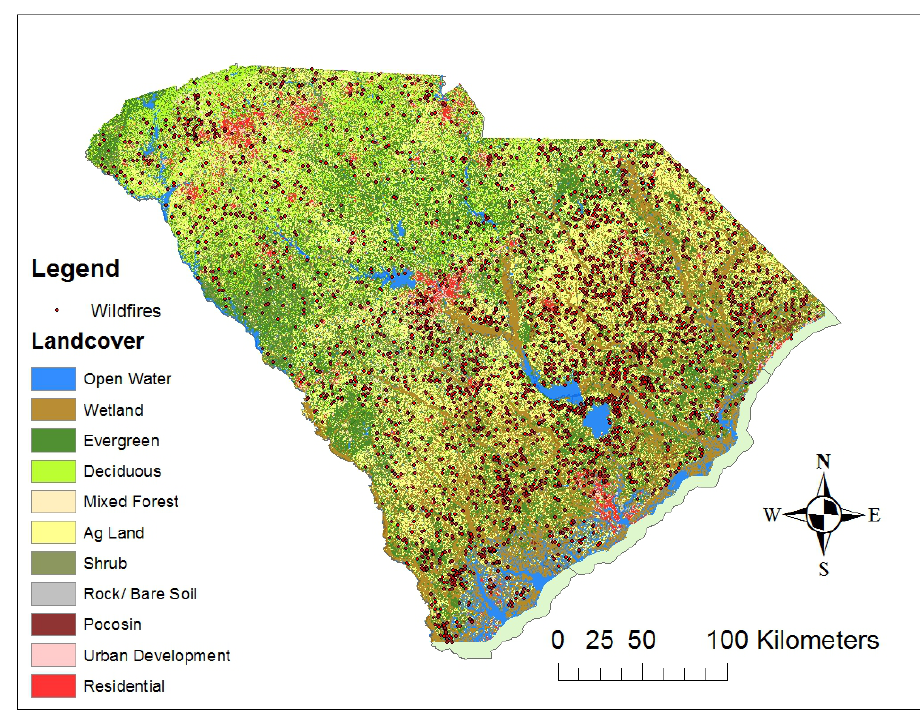
Figure 3. Reclassified land cover map overlaid by wildfires.